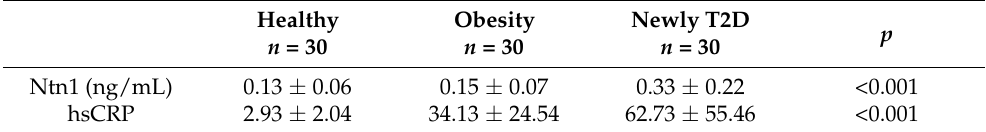
Table 3. Serum concentrations of Ntn1 and